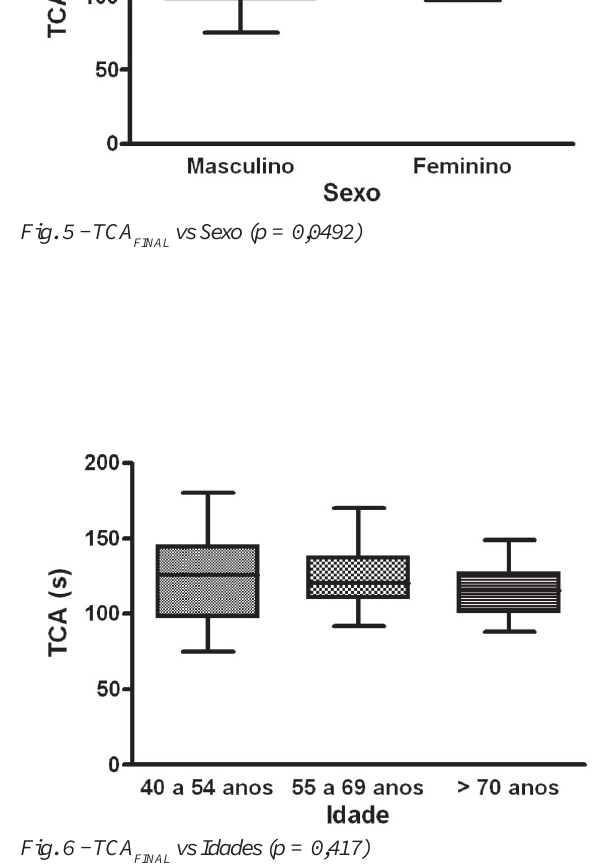
Fig. 6 - TCA vs Idades (p = FINAL